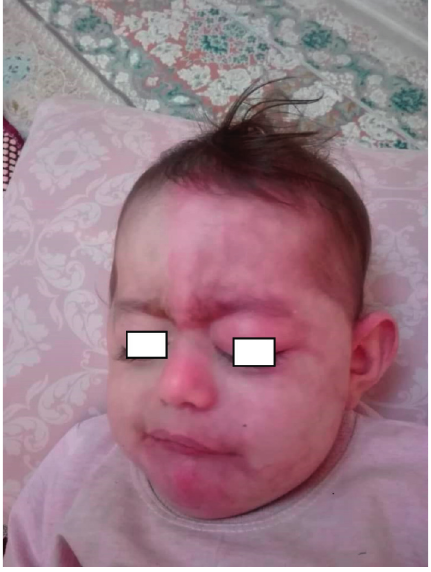
Figure 5: Remarkable resolution of port-wine stain following PDL therapy.